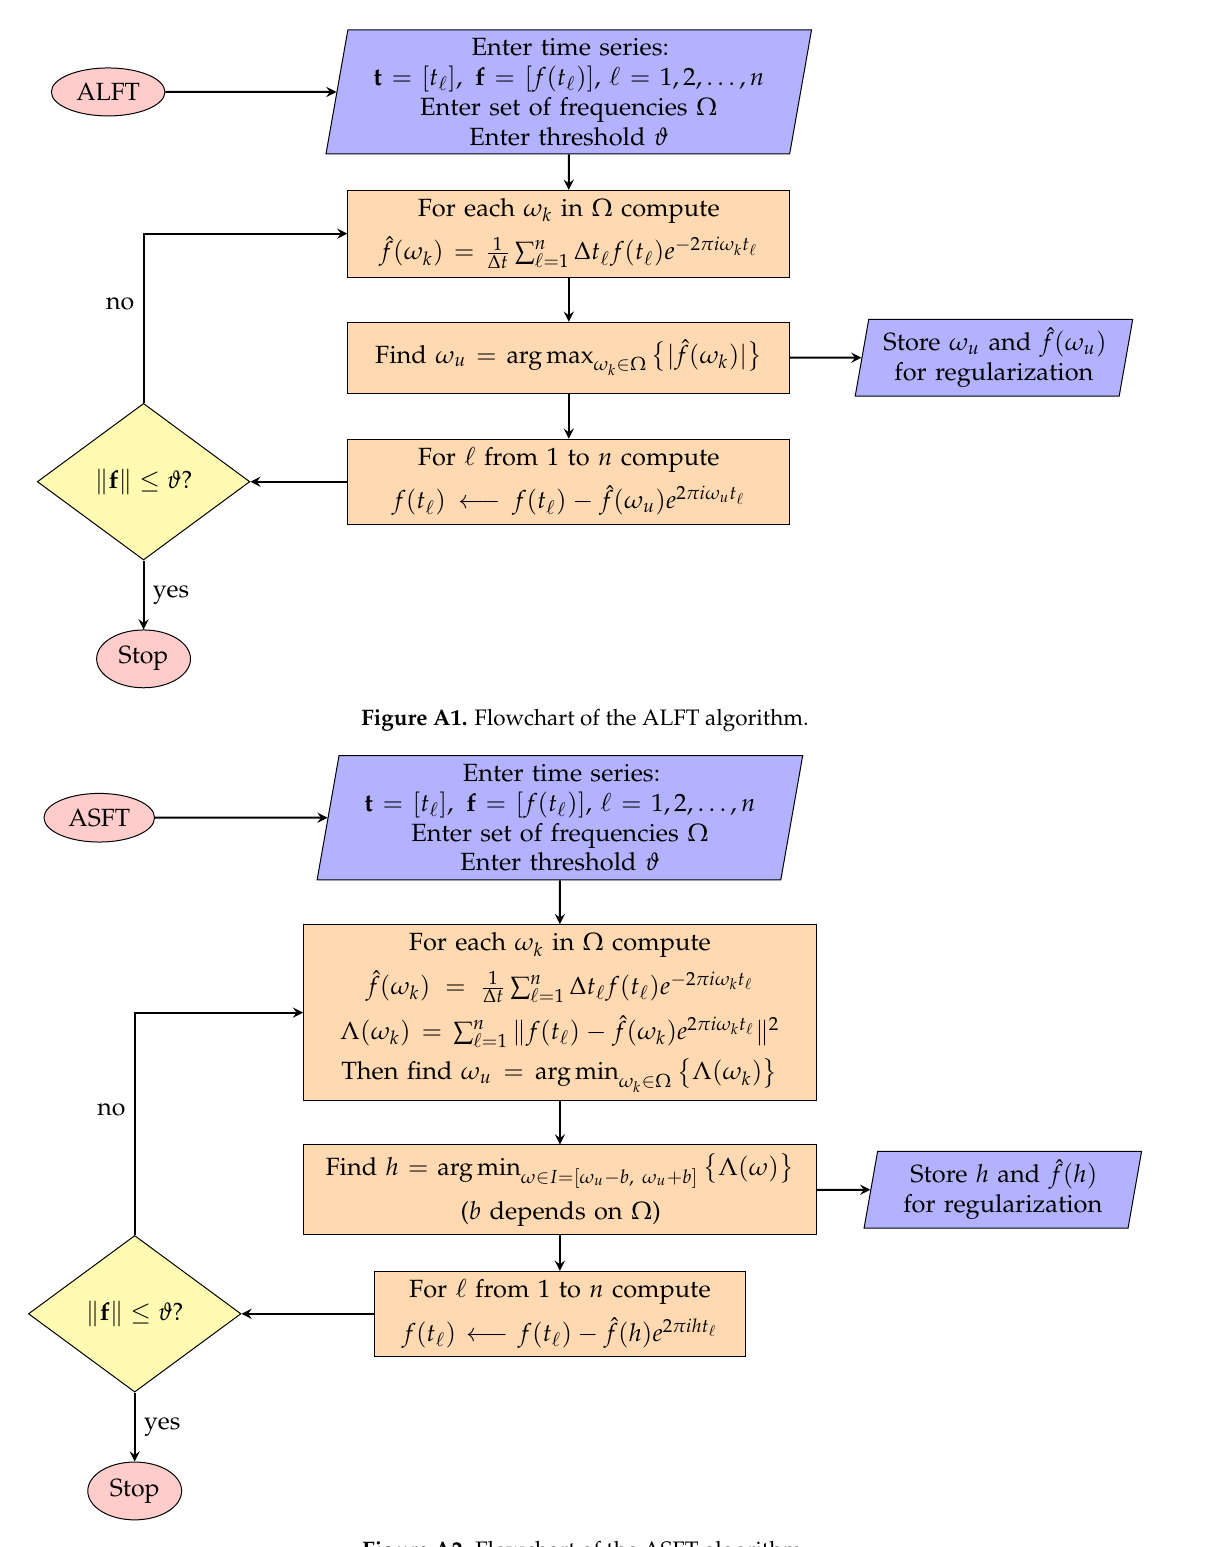
Figure A1. Flowchart of the ALFT algorithm.